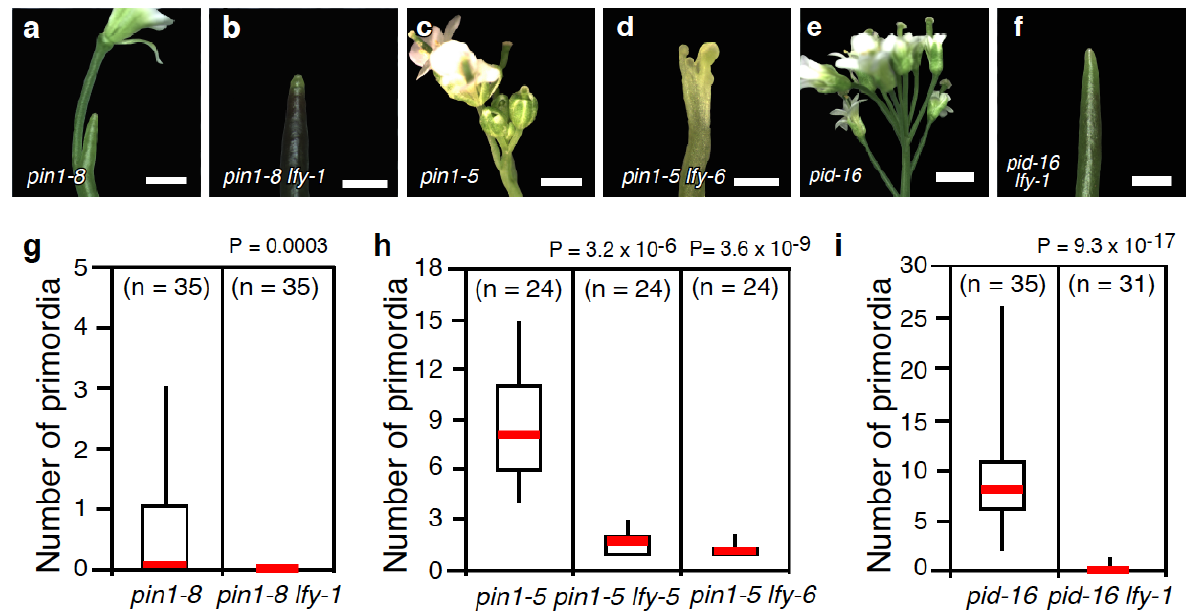
Figure 1. lfy enhances the floral primordium initiation defects of auxin transport mutants. ( a – f ) Close-up view of the inflorescences formed in a strong pin1 mutant allele, pin1-8 ( a ); and pin1-8 lfy-1 ( b ); a weak pin1 mutant allele, pin1-5 ( c ); and pin1-5 lfy-6 ( d ); pid-16 ( e ) and pid-16 lfy-6 ( f ); ( g – i ) Quantification of the flower initiation defects in pin1-8 and pin1-8 lfy-1 ( g ); pin1-5 , pin1-5 lfy-5 , and pin1-5 lfy-6 ( h ); and pid-16 and pid-16 lfy-6 ( i ) . Note that lfy-1 and lfy-6 carry the exact same mutation (Q32stop) but are the Columbia (Col) and Landsberg erecta (L er ) cultivar, respectively. We employ both alleles as to eliminate mixed genetic backgrounds when generating double mutants. Scale bar, 200 µm ( a , b , d , f ), 5 mm ( c , e